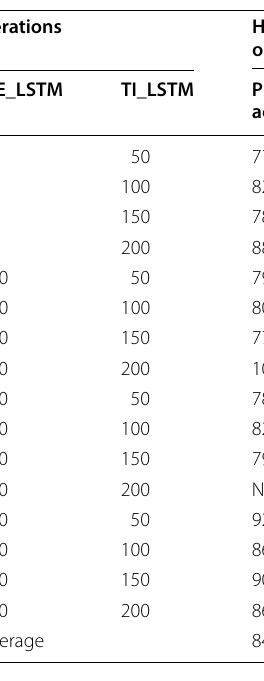
Hybrid model‑modification based on TI_LSTM